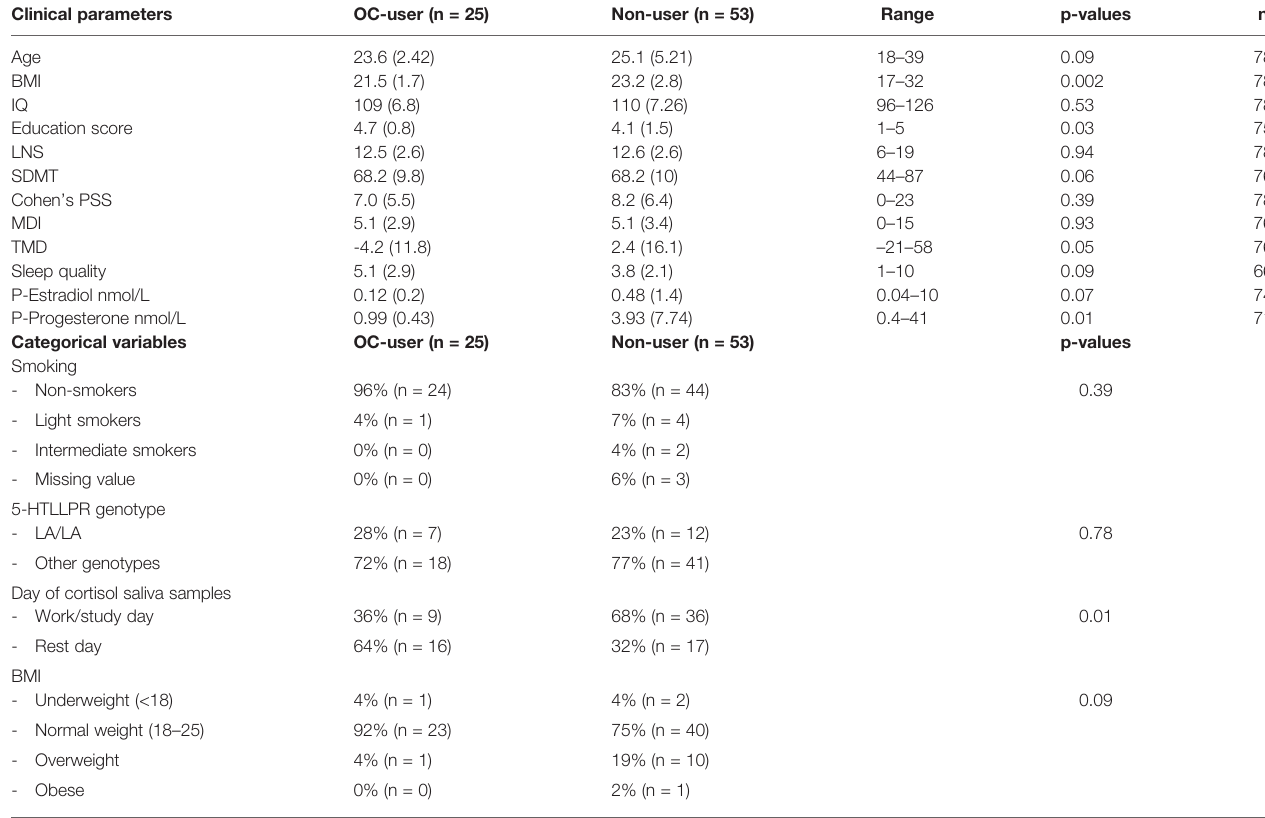
TABLE 1 | Demographic, cognitive, psychometric, and hormonal data. Clinical parameters